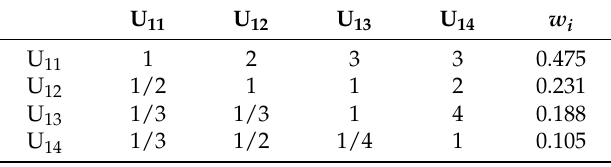
Table 4. Judgment matrix and validation of consistence for surface index.